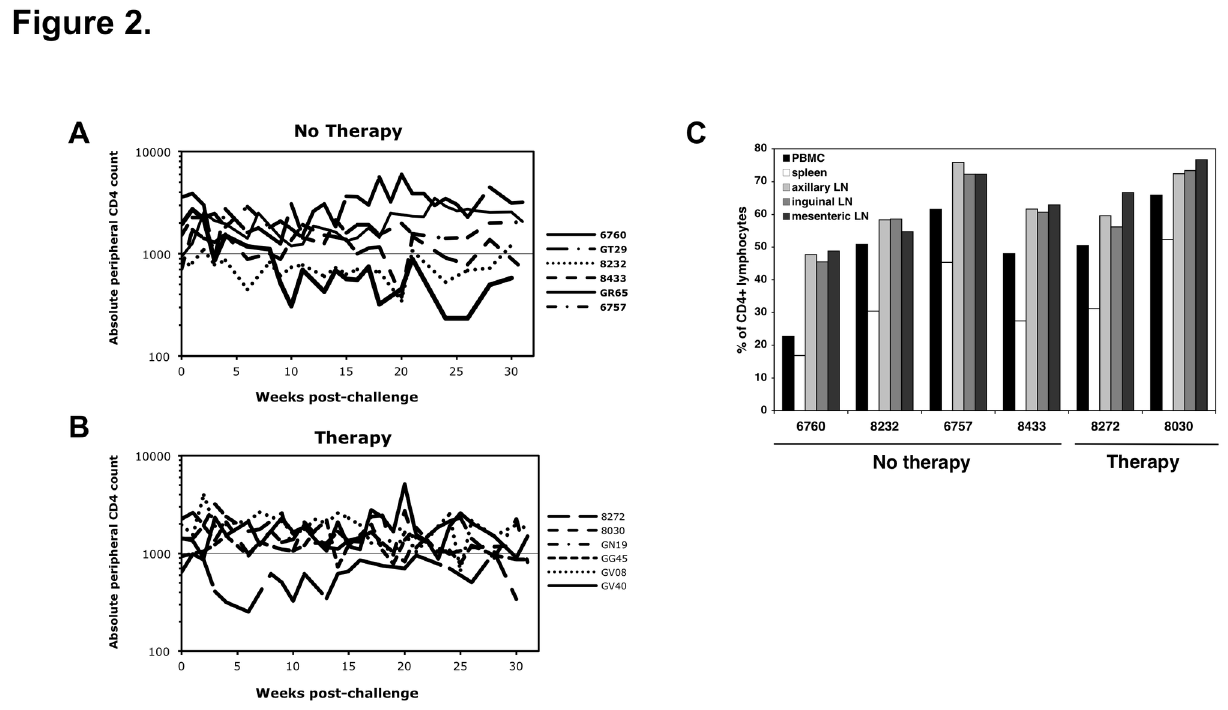
Figure 2. CD4 numbers in PBMC and tissues. Absolute CD4 counts in the blood of (A) untreated and (B) treated animals were plotted from multiple time points. (C) The percentage of CD4+ lymphocytes in PBMC, spleen and multiple lymph nodes taken at necropsy in 6 animals are